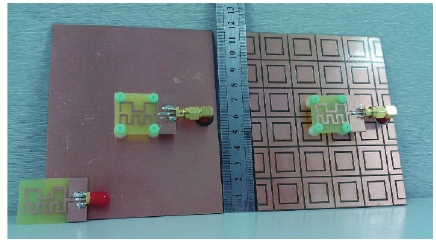
Figure 12: Photograph of three different antenna designs.